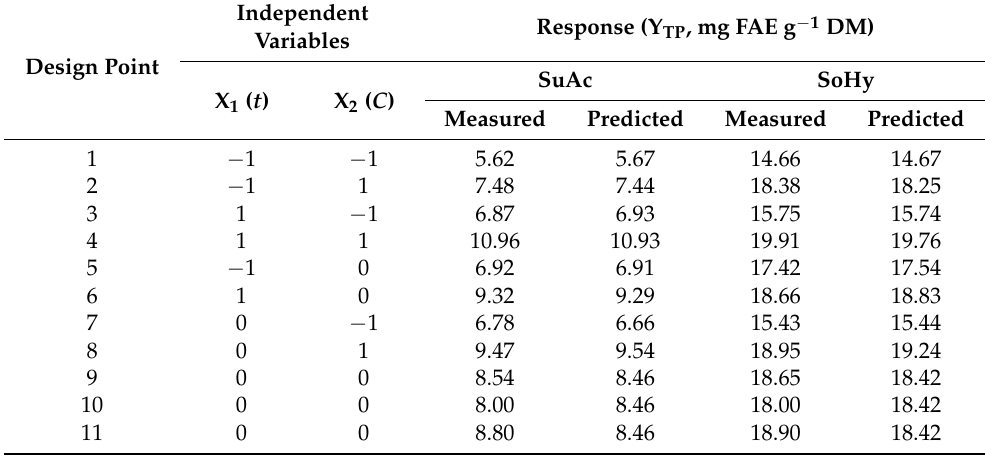
Figure 4. Plot showing the function of desirability ( A ) and the actual vs. predicted values ( B ), for the optimization of polyphenol release from WB using sodium hydroxide (SoHy) as a catalyst. The inset tables present the statistical data related to the model built based on the response surface methodology. Values designated with different colors and asterisks are statistically significant. Table 3. The design points included in the response surface methodology, and the values (measured and predicted) of total polyphenol yield (Y TP ), obtained for both acid- and alkali-catalyzed